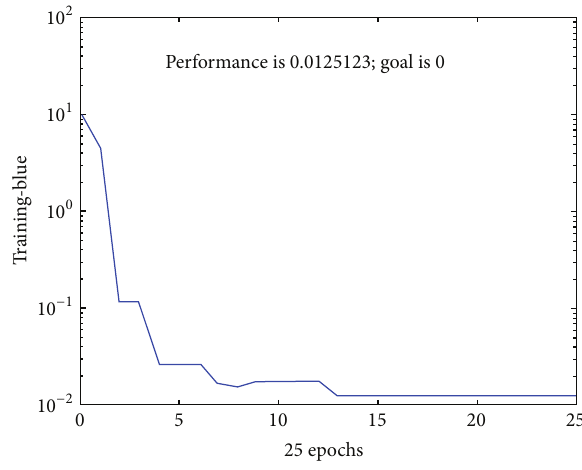
Figure 6: Mean squared error of the network to predict upset of